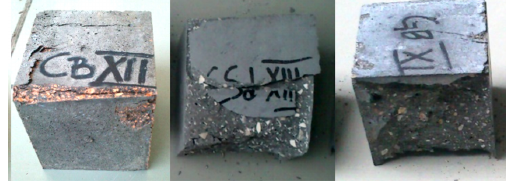
Figure 3. Damage samples from left to right: BC, SC,